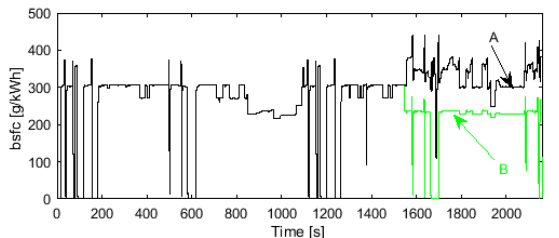
Figure 15. Brake specific fuel consumption A) Without generator, B) With generator